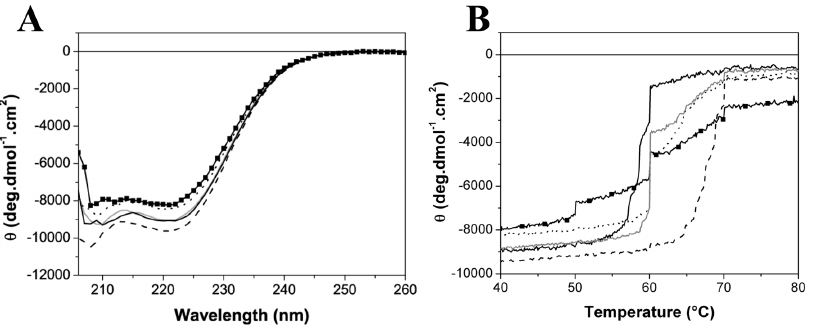
Fig 2. Far UV CD experiments of TtgR WT and variants in the absence of effectors. (A) Far UV CD spectra at 30°C. (B) Thermal unfolding of TtgR WT and mutants monitored by CD ellipticity at 222 nm. Variants are represented in grey line (TtgR WT ), black solid line (TtgR H114A ), black dashed line (TtgR N110A ), black dotted line (TtgR E78A ) and black squares and line (TtgR S77A